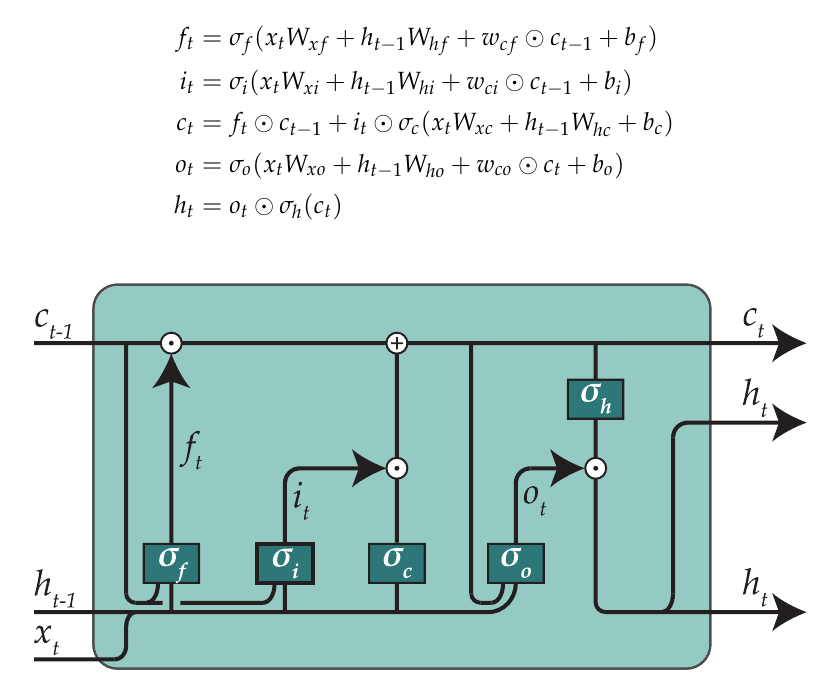
Figure 5. Typical structure of a LSTM